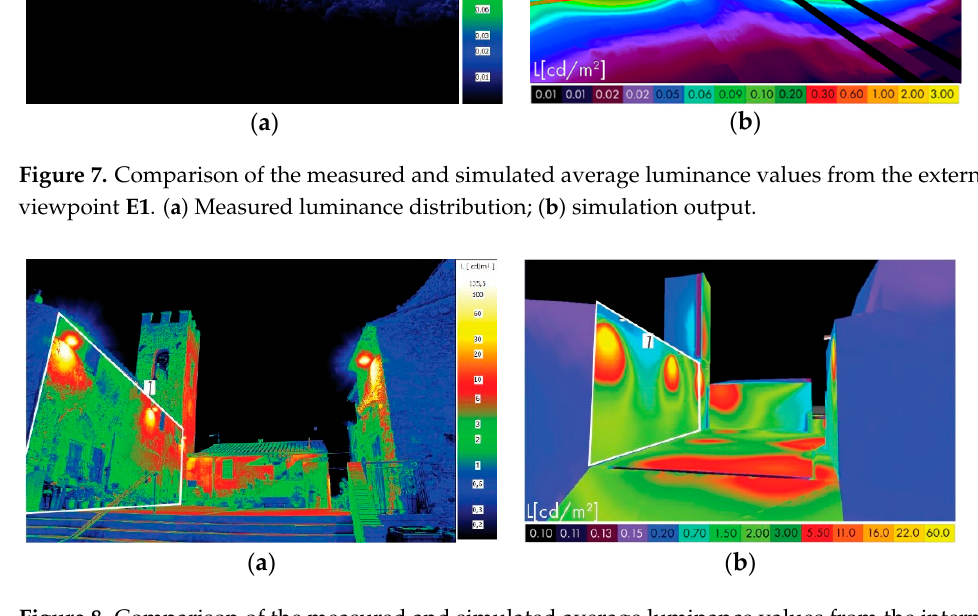
Figure 7. Comparison of the measured and simulated average luminance values from the external viewpoint E1 . ( a ) Measured luminance distribution; ( b ) simulation output. Table 3. Comparison of the measured and simulated average luminance values from the external viewpoint E1 . (1) Bell tower (2) residential building (3) residential building (4) Historic wall.